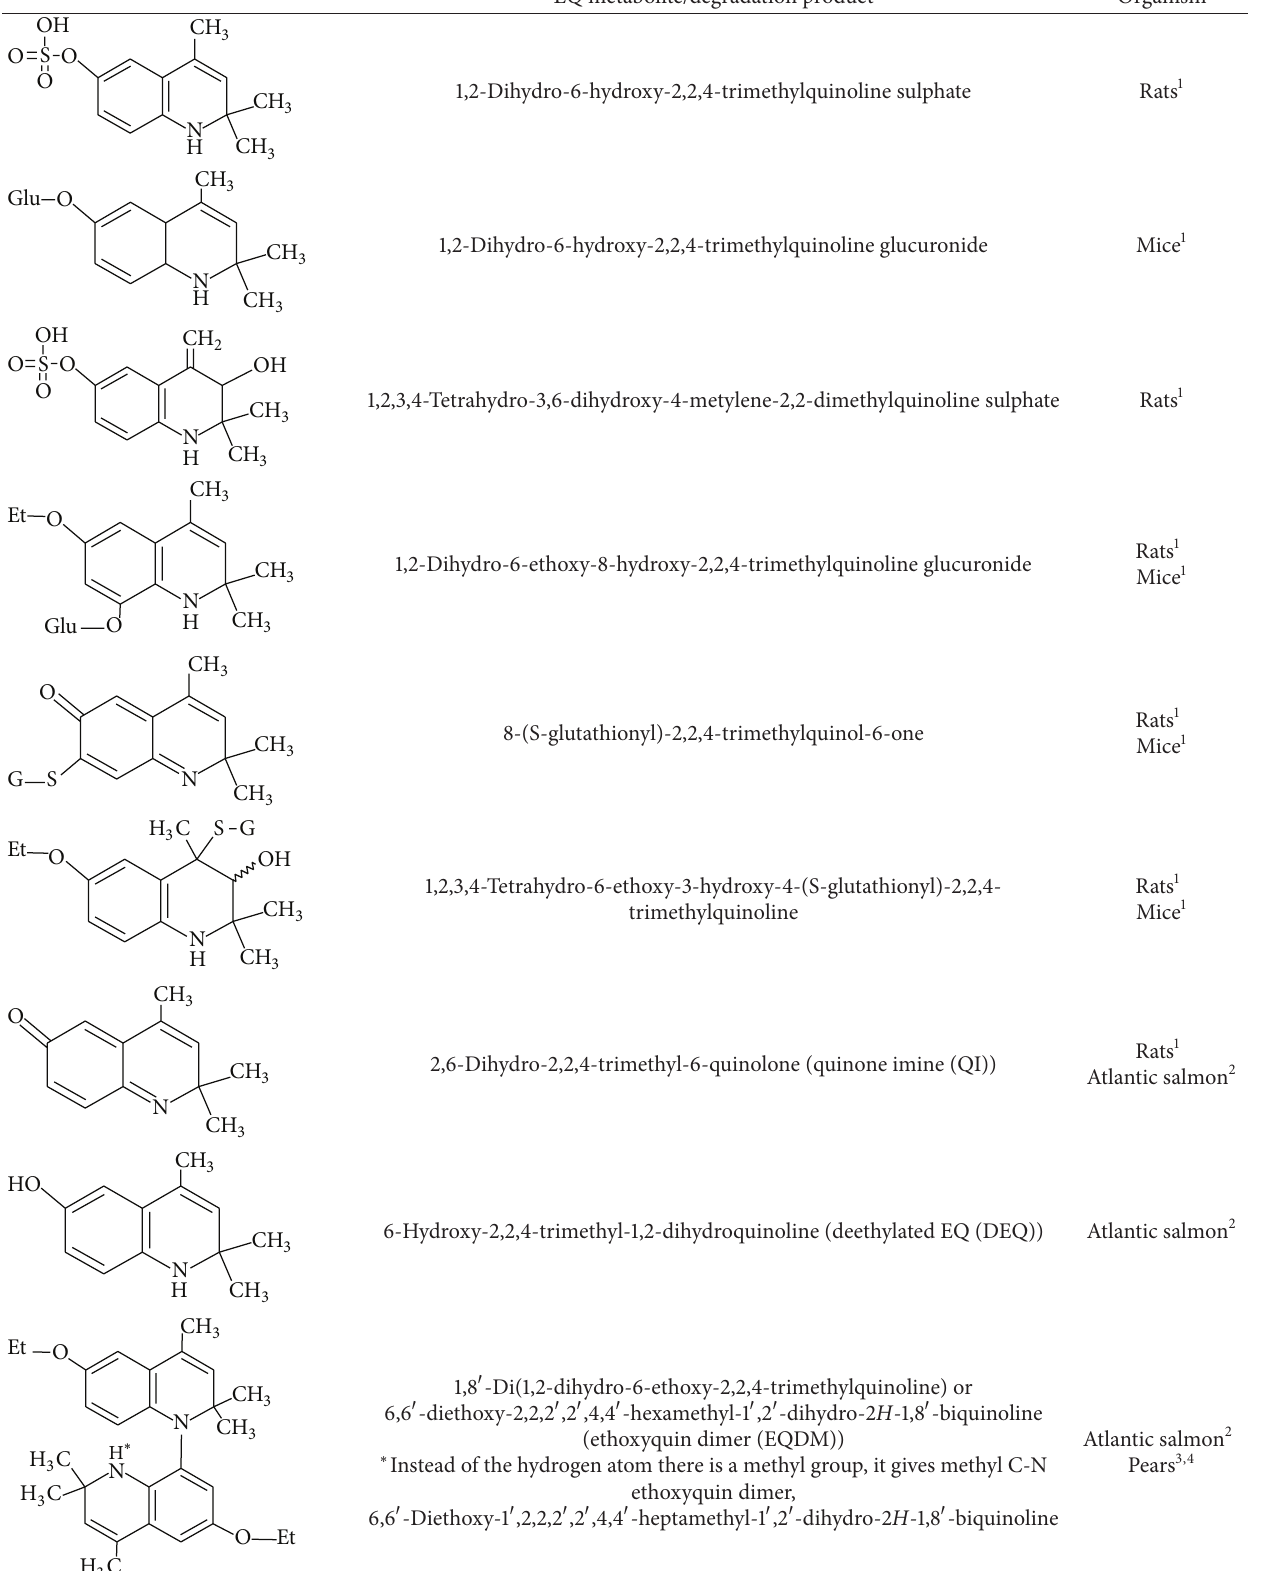
Table 3: Metabolite/degradation products of EQ detected in different organisms. EQ metabolite/degradation product